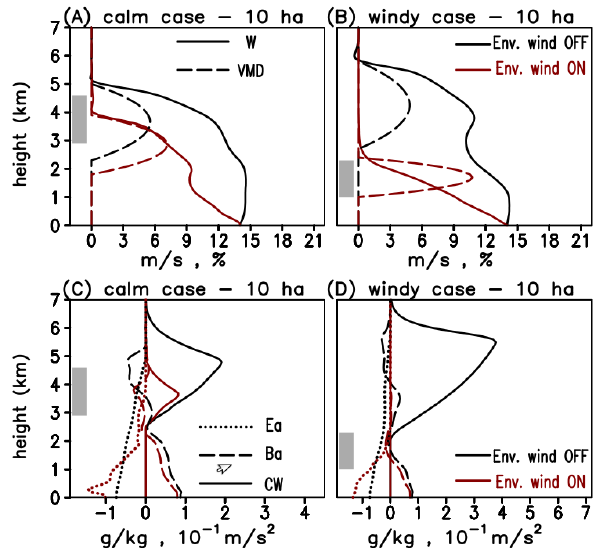
Figure 5. Results from the one-dimensional plume rise model (PRM) of Freitas et al. (2007, 2010) for a fire burning in (a, c) calm and (b, d) windy atmosphere scenario, as studied by Freitas et al. (2010). The fire has an active fire area (AF area) of 10ha. The quan- tities shown are vertical velocity (W, ms − 1 ), vertical mass distribu- tion (VMD, %), entrainment acceleration (Ea, 10 − 1 ms − 2 ), buoy- ancy acceleration (Ba, 10 − 1 ms − 2 ), and total condensate water (CW, gkg − 1 ). Model results considering the environmental wind drag are shown in red, whilst those in black depicts the results from simulations disregarding this effect. Grey rectangles indicate the main injection height simulated by the three-dimensional ATHAM model (Trentmann et al., 2006) for the same fire scenario. Fig- ure from Freitas et al.